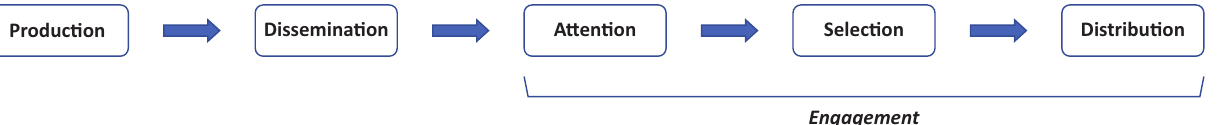
Figure 1. News production, dissemination, and engagement process on Facebook, adapted from Dutceac Segesten et al.